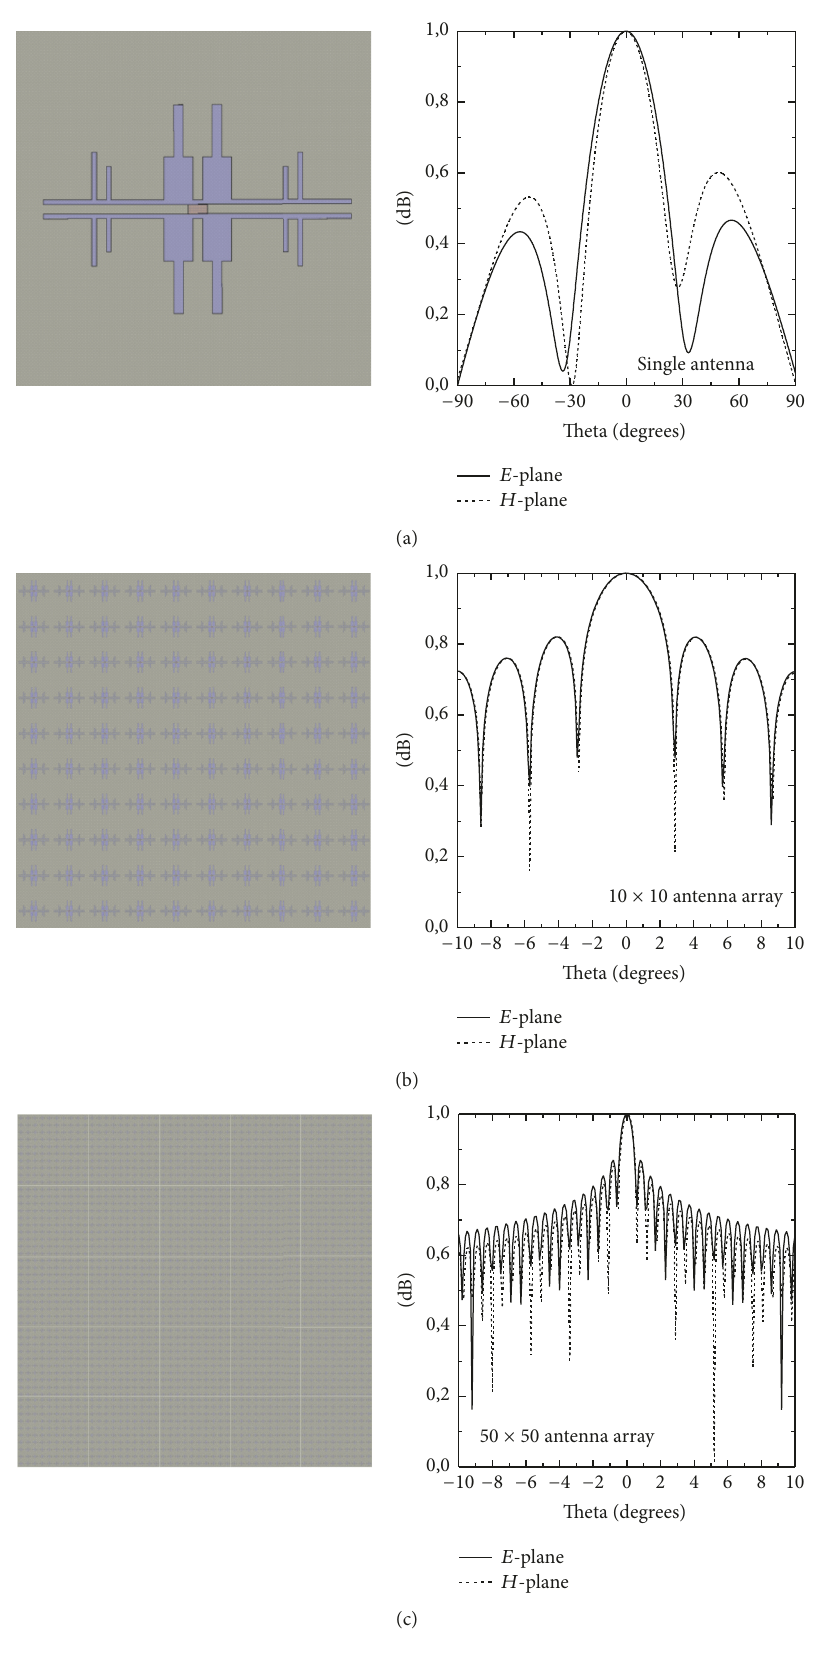
Figure 4: Gain patterns relative to the maximum for a single antenna, for an array of 10 × 10 elements, and for an array of 50 × 50 elements. The squared backgrounds correspond to pixel areas of 20 × 20 𝜇 m 2 (a), 200 × 200 𝜇 m 2 (b), and 1000 × 1000 𝜇 m 2 (c),